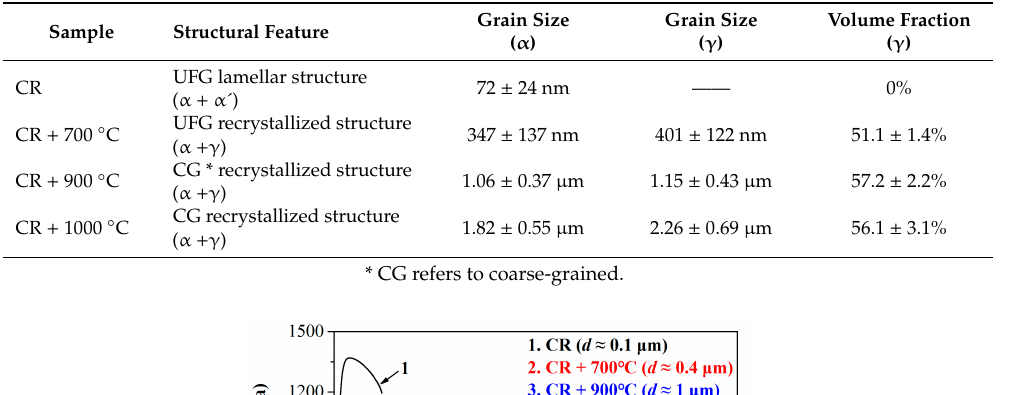
Table 1. Structural parameters of samples cold-rolled and annealed.